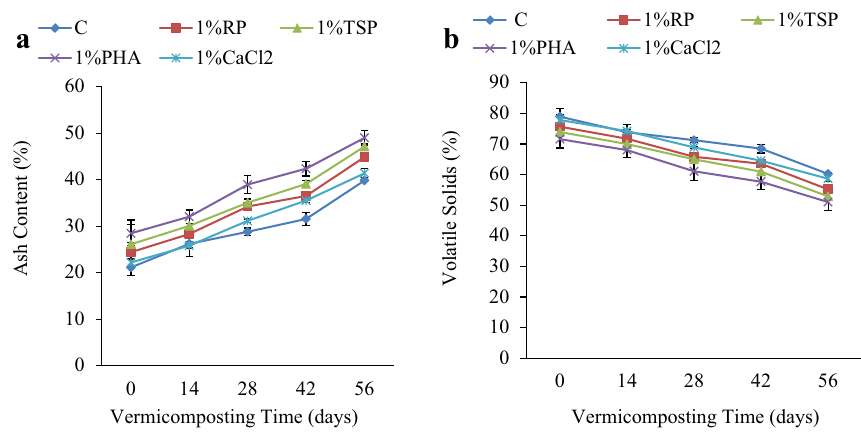
Fig. 1 Effect of P and Ca bear- ing sources on the percentage ash and VS